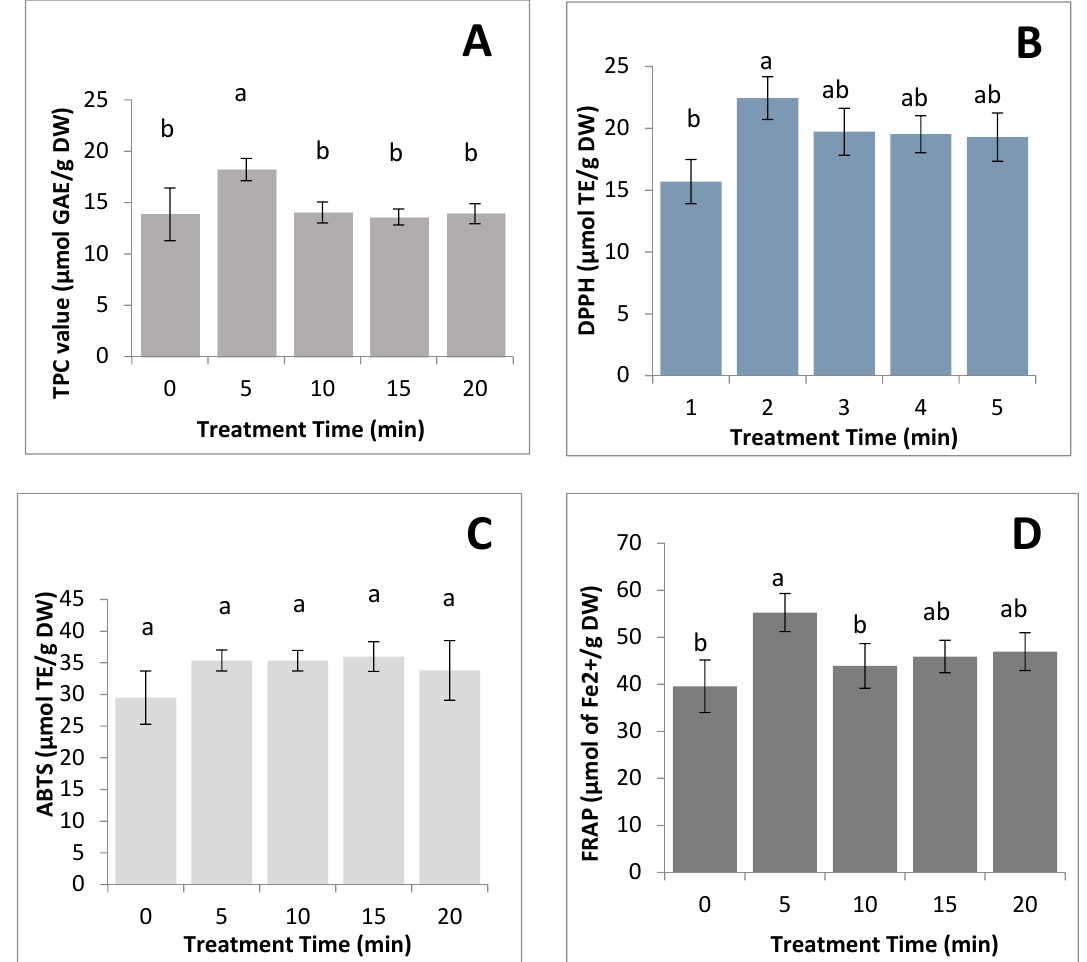
Figure 1. Effect of different treatment time of hot water on antioxidant activity in silkworms. ( A ) Total phenolic compound (TPC), ( B ) DPPH free radical scavenging assay, ( C ) ABTS assay, and ( D ) ferric reducing antioxidant power (FRAP). The results were expressed as mean ± SD of triplicate measurements. The different letter on the bar indicates significantly difference among treatment ( p < 0.05).